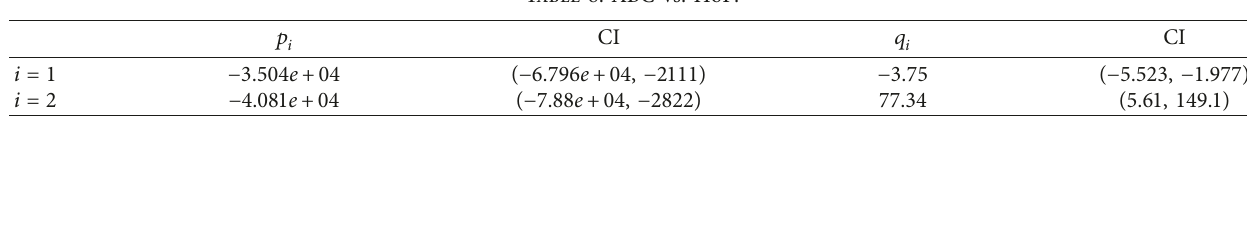
Table 8: ABC vs. HoF.